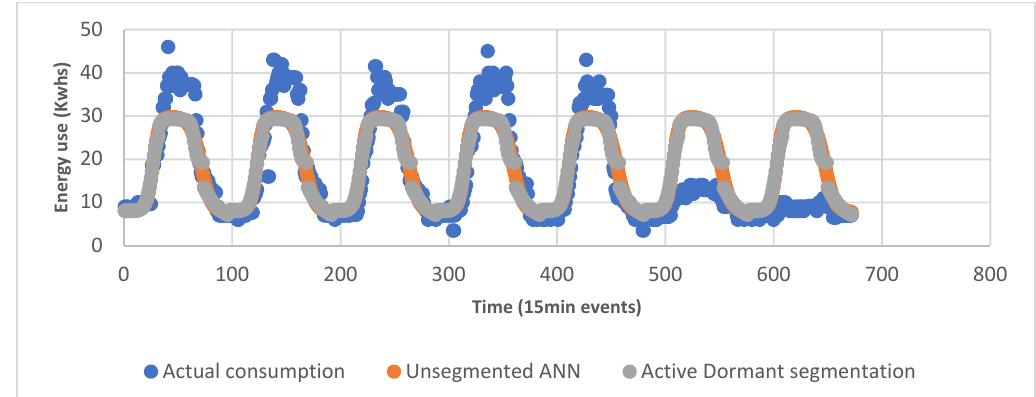
Figure A9. A comparison of weekday and weekend segmented weekly ANN predictions, to actual consumption and the unsegmented predicted consumption, in the first week of autumn.